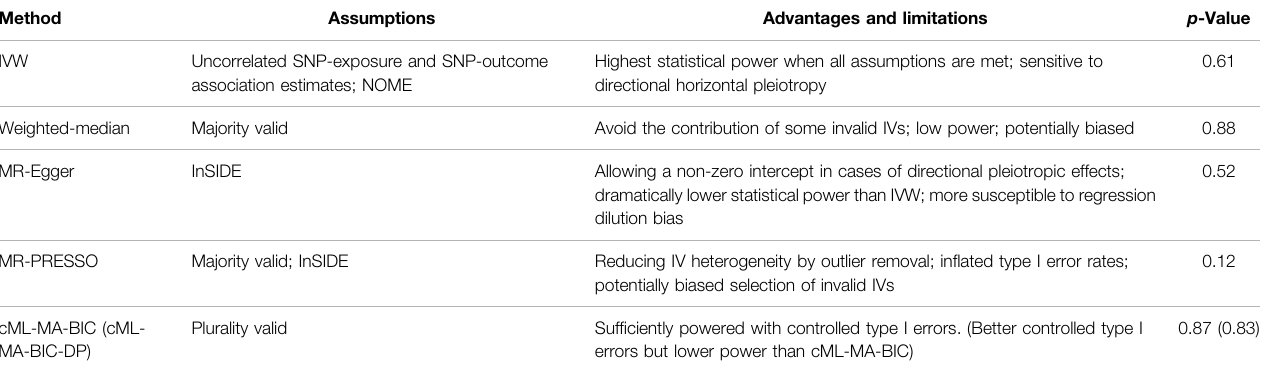
TABLE 1 | Mendelian randomization methods used in this study for assessing the association between selenium levels and the risk in developing amyotrophic lateral sclerosis (ALS). Method